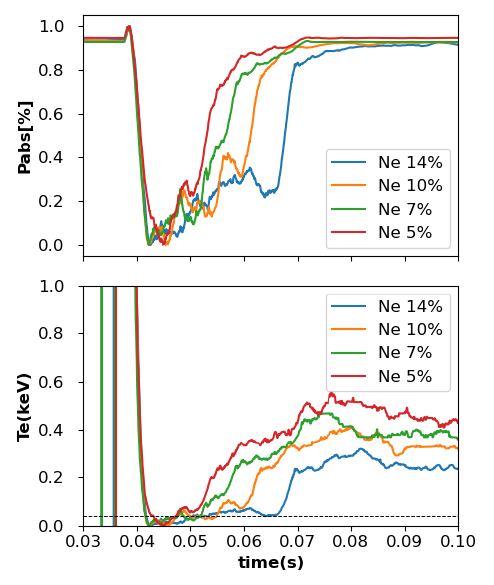
Figure 7. Top: Absorption calculated interpolating non cali- brated sni ff er probe signals between 0 (no absorption) and 1 (full single pass absorption). Bottom: T e derived using line integrated n e and assuming flat density profile.